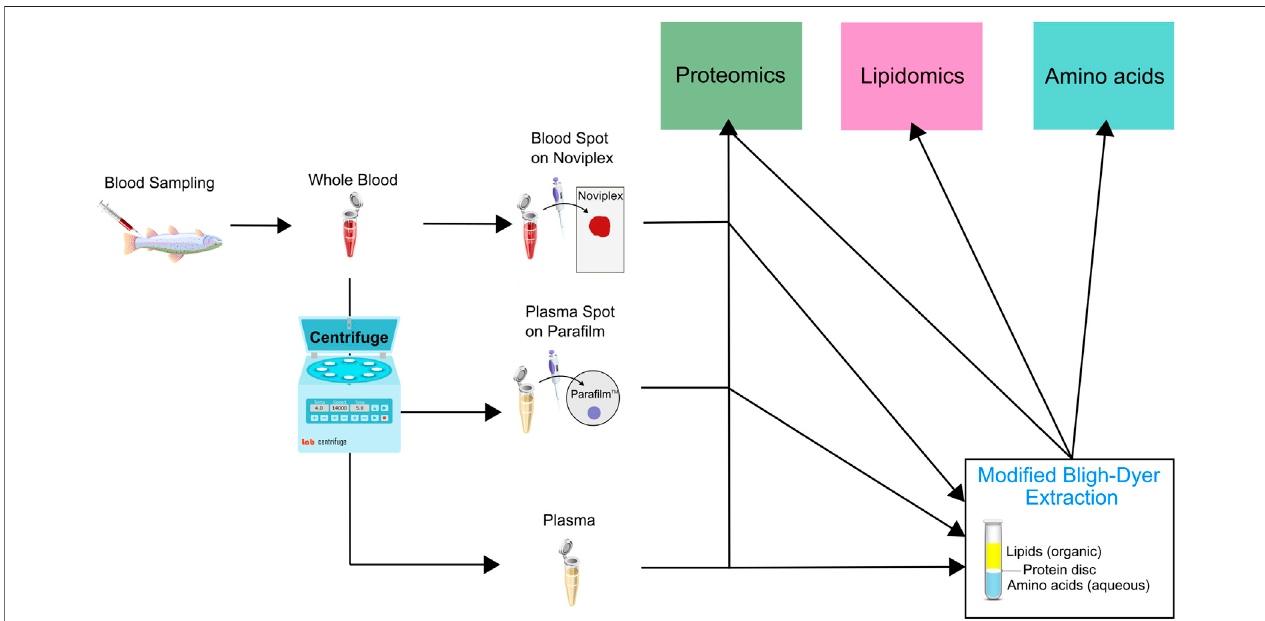
FIGURE2| Schematicillustratingthesamplepreparationpipelineusedforuntargetedproteomic,lipidomicandanalysisusingLCMS/MS.Brie fl y,wepooledwhole blood from 20 rainbow trout and underwent sample preparation through three initial channels which were either a blood spot on Noviplex (NP), plasma spot on para fi lm (PF)orjustregularwetplasma(WP).Thethreetypesofsampleswerethenrunthroughtwochannelswhichwere1)directlyenteringtheproteomicssampleextraction or 2) entering a modi fi ed Bligh-Dyer extraction which was then run through the three different extraction protocols (proteomics, lipidomics and amino acids). The PF Disc and WP Disc are used to refer to proteomics results from samples prepared using the modi fi ed Bligh-Dyer extraction.